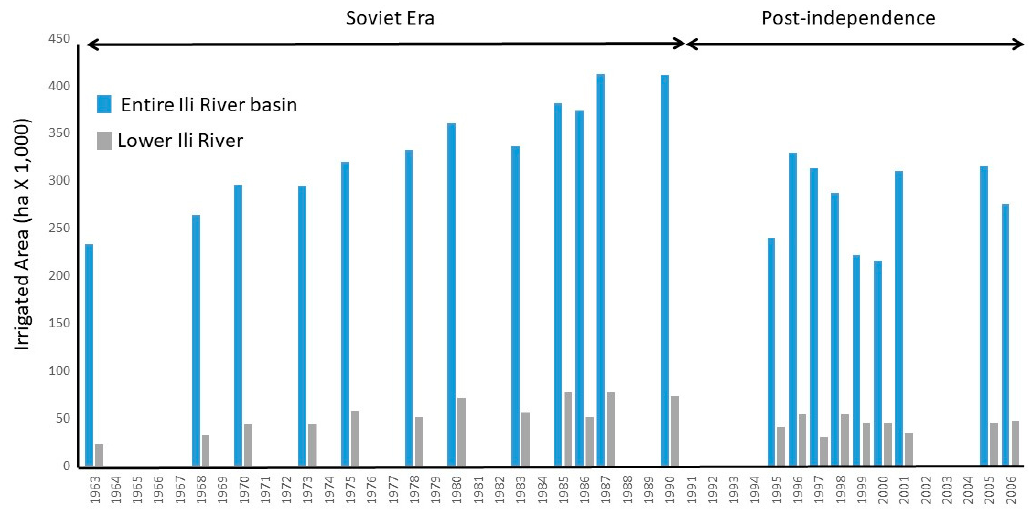
Figure 2. Changes in irrigated area within the lower Ili River basin prior to and after Kazakhstan’s independence from the Soviet Union. The data, which span 1963 to 2006, are not available for all years and are from previously cited statistical sources [2,62]. The lower Ili River constitutes the area below the dam site.